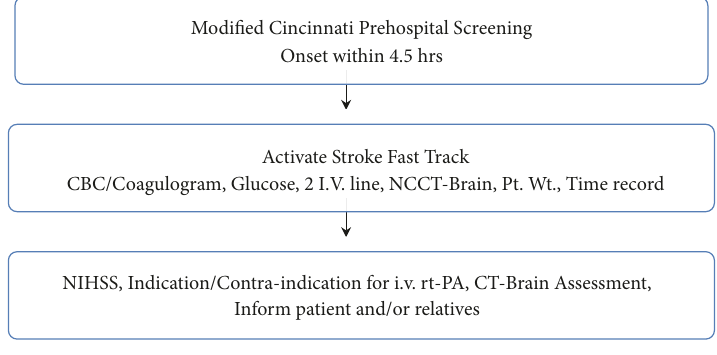
Figure 1: The flow chart of Stroke Fast